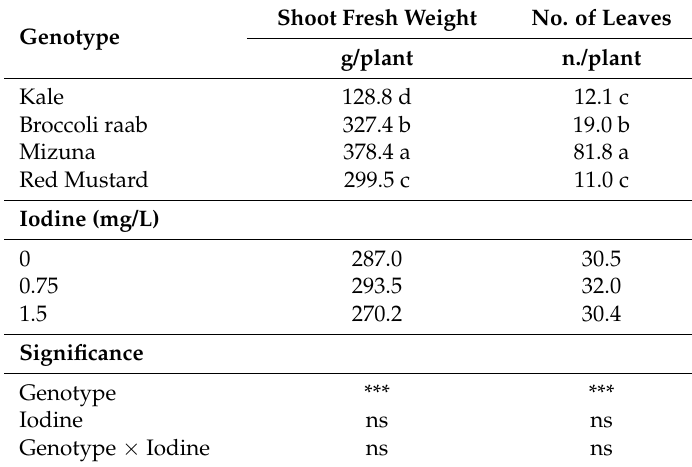
Table 1. Biometric parameters of Brassica genotypes supplied with different levels of I in the nutrient